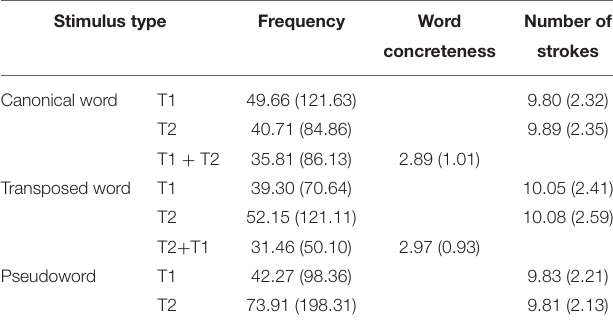
TABLE 1 | Descriptive statistics (mean and SD) of the frequency, word concreteness, and number of strokes of the three stimulus types and their